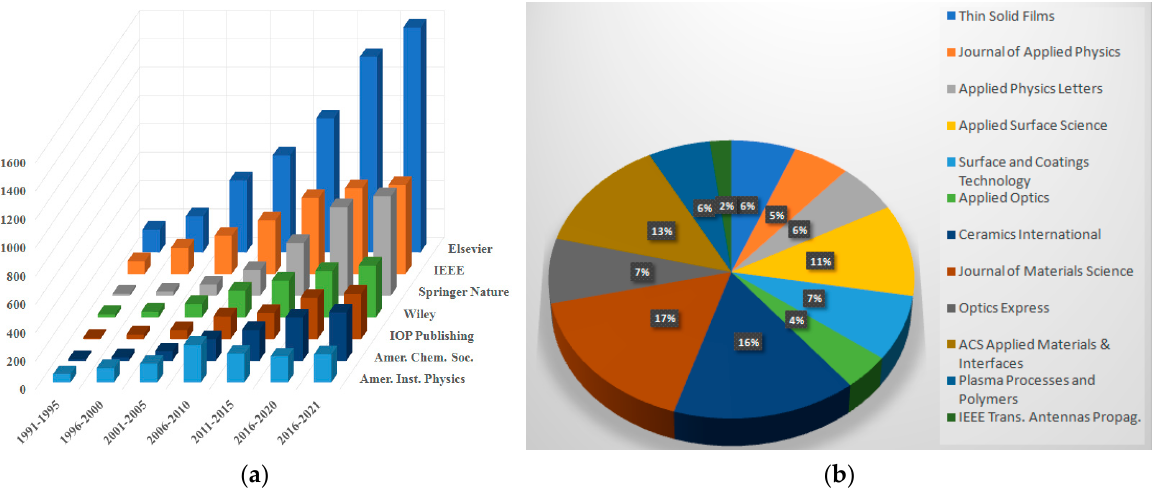
Figure 1. Publication dynamics on dielectric coatings and their breakdown by publishers ( a ), and the set of the journals publishing articles on “dielectric coatings” ( b ).